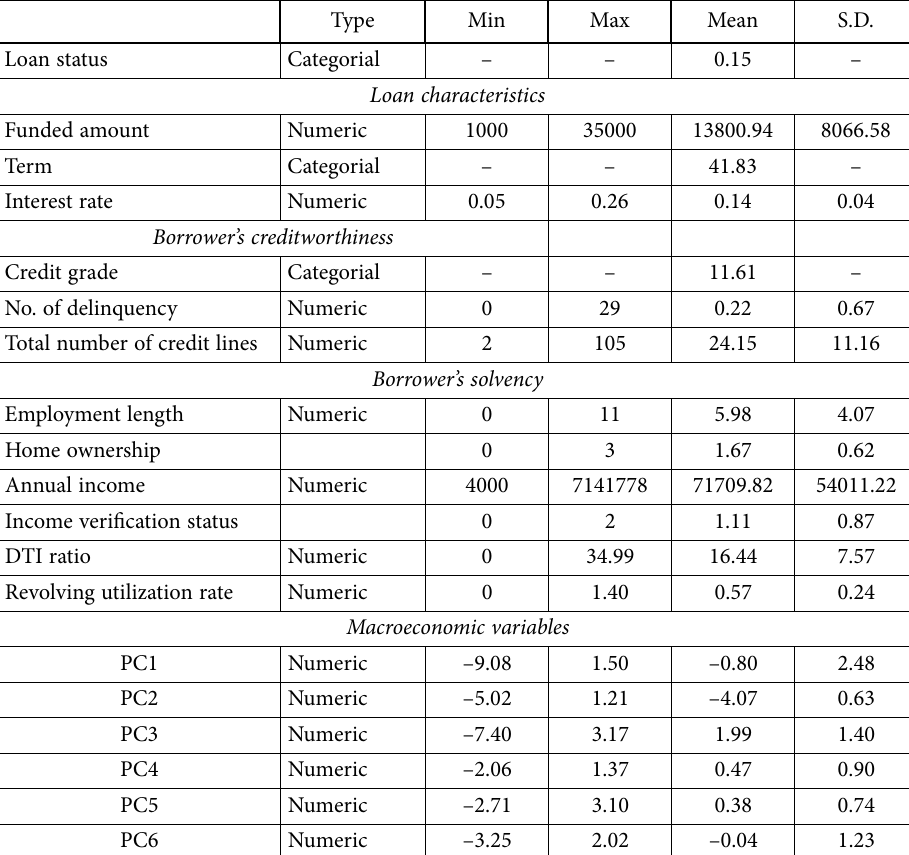
Table 2. Summary statistics of the